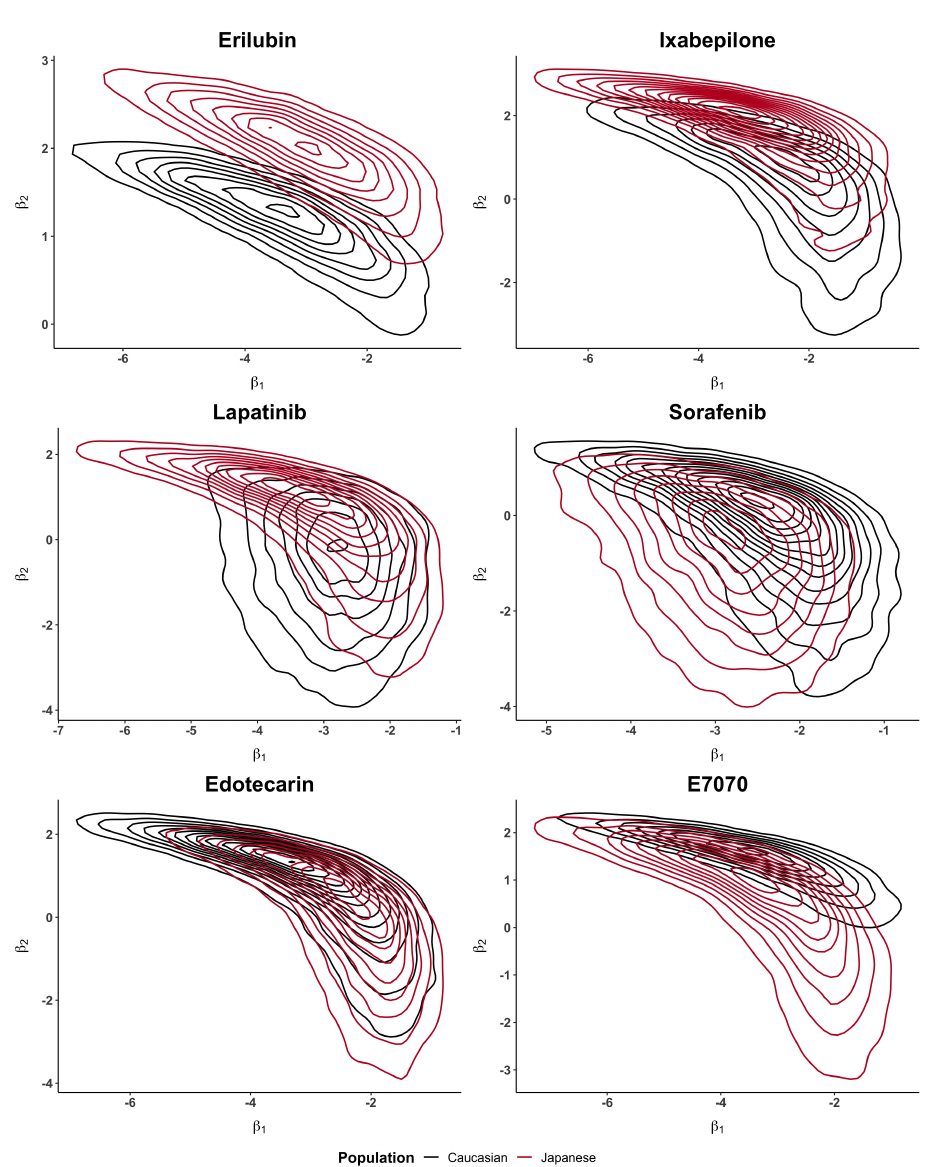
Figure A2. Bivariate posterior distributions of β 0 and β 1 when using d mod for the real case studies shown in Table